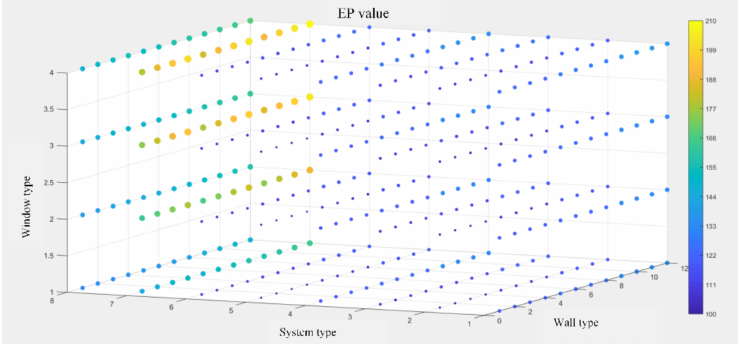
Figure 4. The values of the EP objective function in the space of decision variables (wall type, window type, and system type).